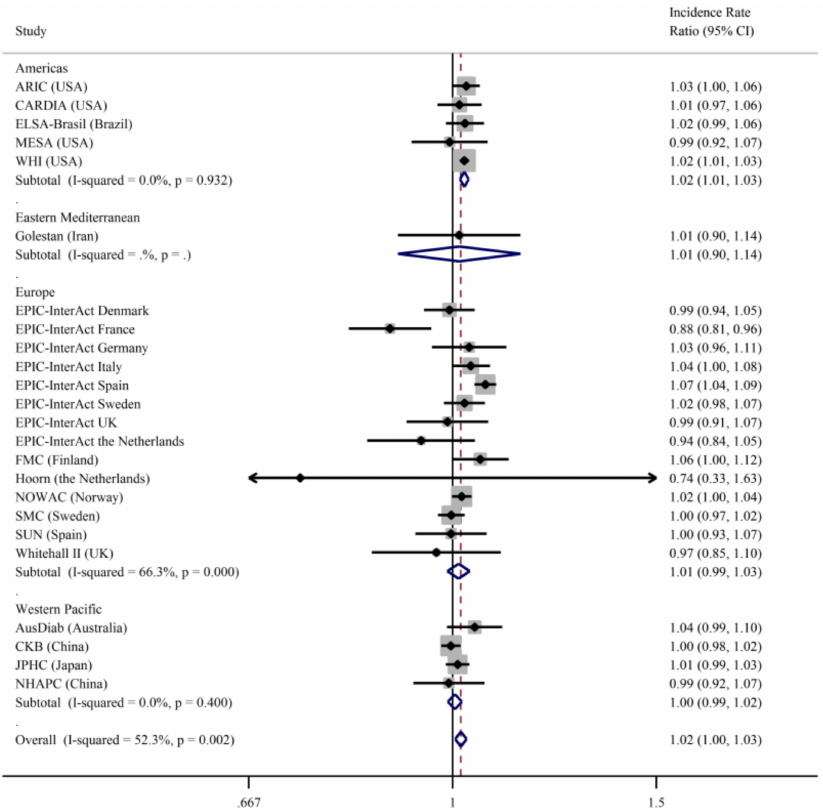
Figure 2. Incidence rate ratios and 95% confidence intervals for the association between the consump- tion of total fish (per 100 g/day) and incident type 2 diabetes (primary outcome) in women in the InterConnect project. Model 1 (upper panel) adjusted for age, education, smoking, physical activity, alcohol intake, BMI, comorbidities at baseline. Model 2 (lower panel) was additionally adjusted for dietary factors: energy intake, intake of fibre, red and processed meat, fruit, vegetables, sugary drinks. ARIC—Atherosclerosis Risk in Communities; CARDIA—Coronary Artery Risk